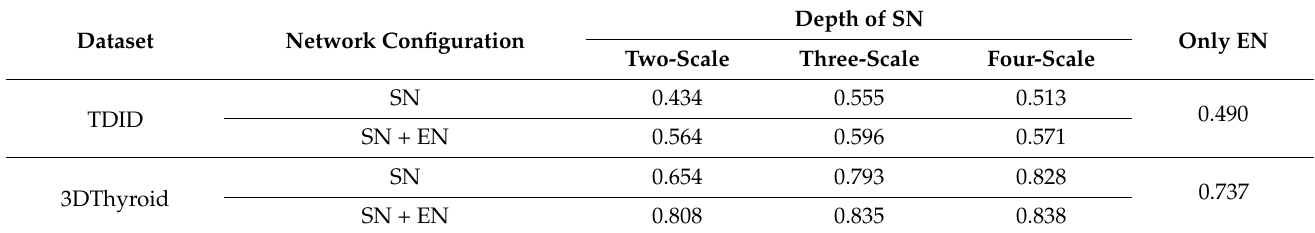
Table 7. Segmentation results (DSC) of the TDID dataset according to the depth of the